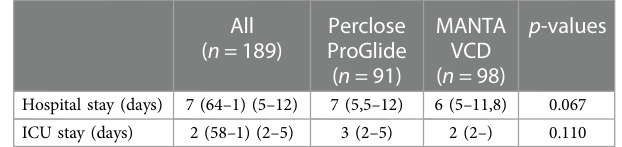
TABLE 3 Length of hospitalization. TABLE 5 Complications.